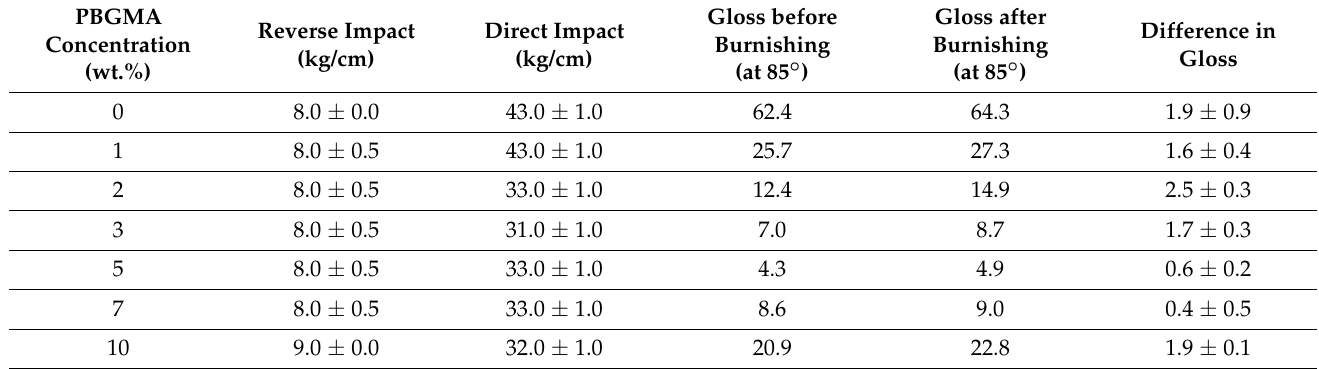
Table 6. Direct and reverse impact, and burnish resistance of each film, at different PBGMA concen-